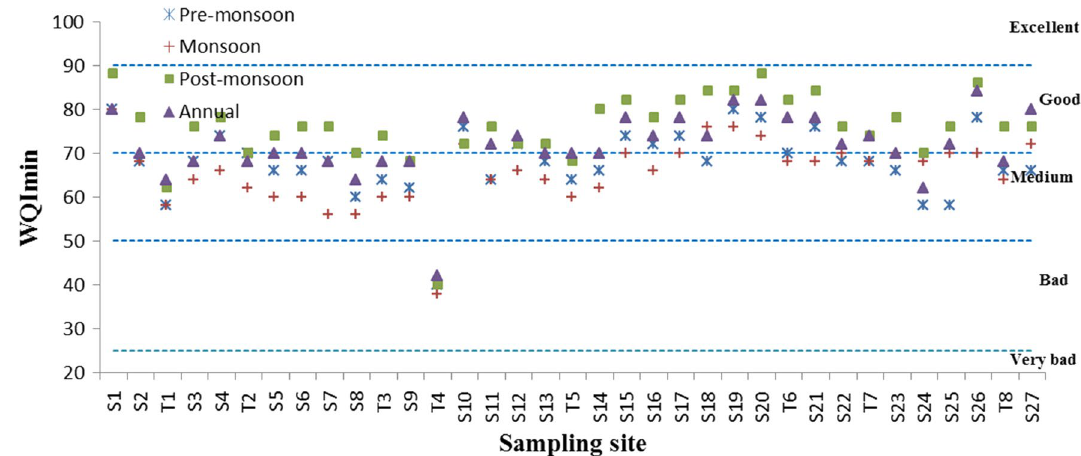
Fig. 6 Spatial and temporal variations of WQI